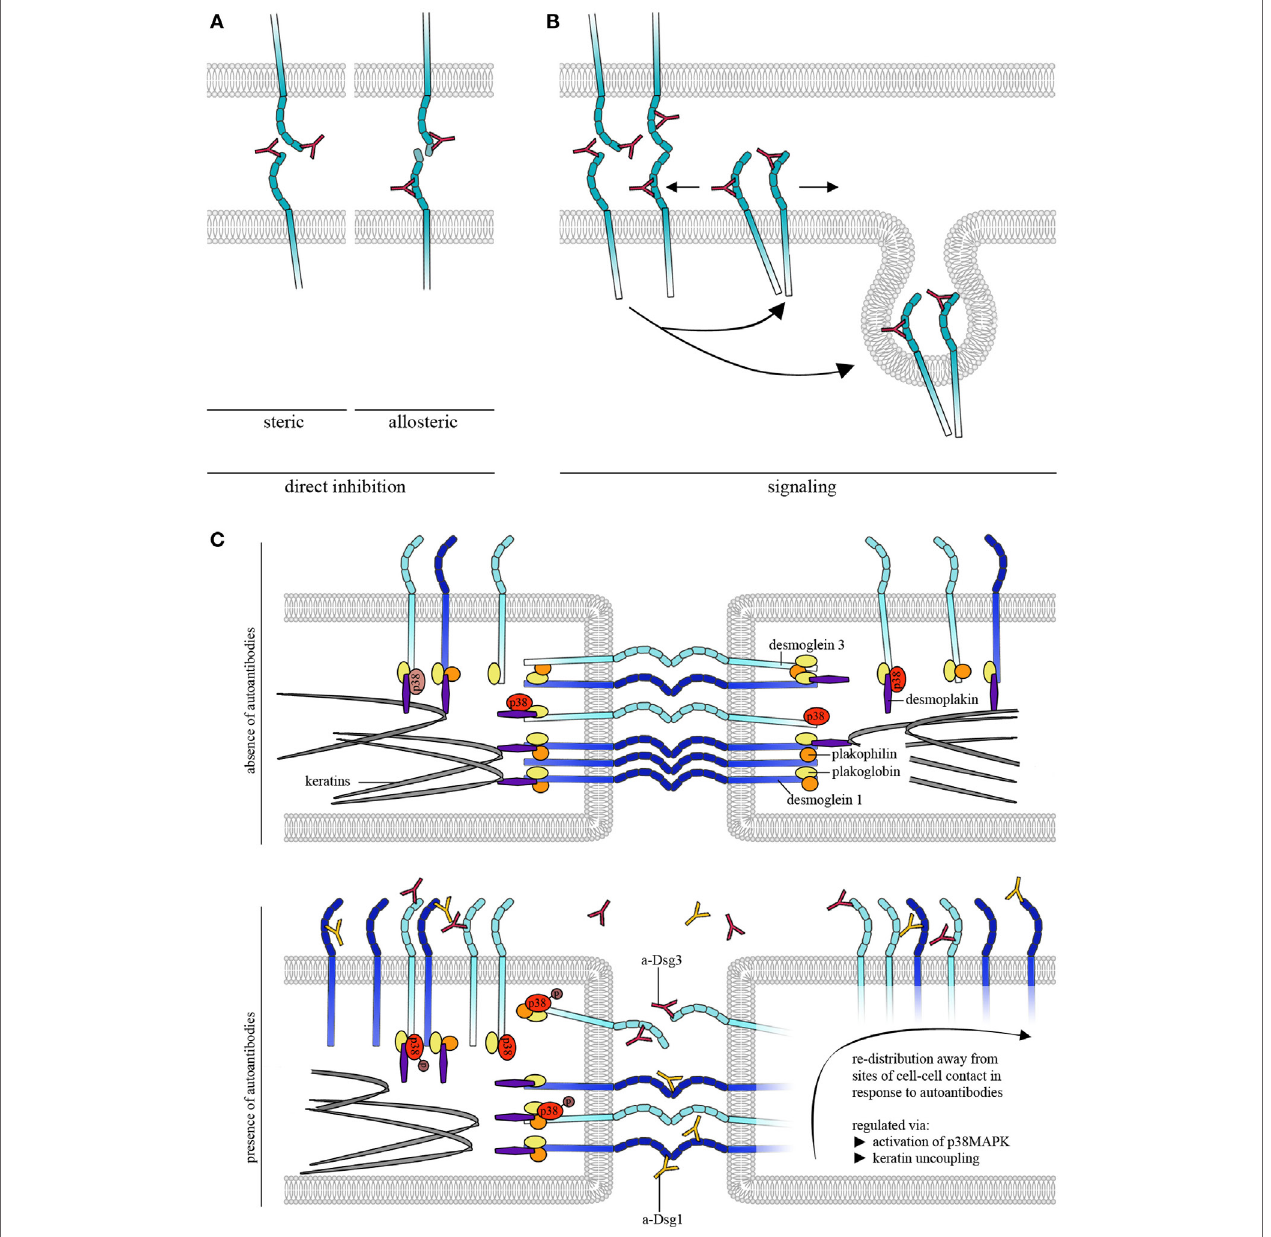
FiGURe 2 | Autoantibody effects on desmosomal cadherin binding properties. (A) To cause direct inhibition of desmoglein (Dsg)-binding autoantibodies may either sterically hinder desmosomal cadherin interaction by preferentially targeting the adhesive EC1 domain or allosterically lead to conformational changes, which also may involve the adhesive interface. (B) Autoantibodies induce intracellular signaling leading to reorganization and internalization of Dsg molecules. (C) Schematic of autoantibody effects on desmosomal cadherin distribution. For simplification, only Dsgs are shown. Under control conditions, Dsg3 is uniformly distributed over the cell surface whereas Dsg1 shows dense clustering along cell–cell contacts. Binding of pathogenic autoantibodies causes direct inhibition of Dsg3 but not of Dsg1 interactions. For both, Dsg1 and 3, binding of autoantibodies induces redistribution of binding events away from cell–cell contact sites, a process that is likely regulated through by keratin uncoupling and activation of